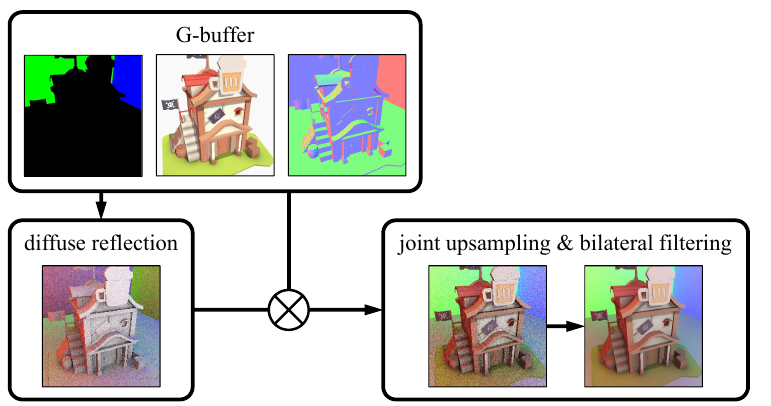
Figure 10. Our rendering pipeline in order.